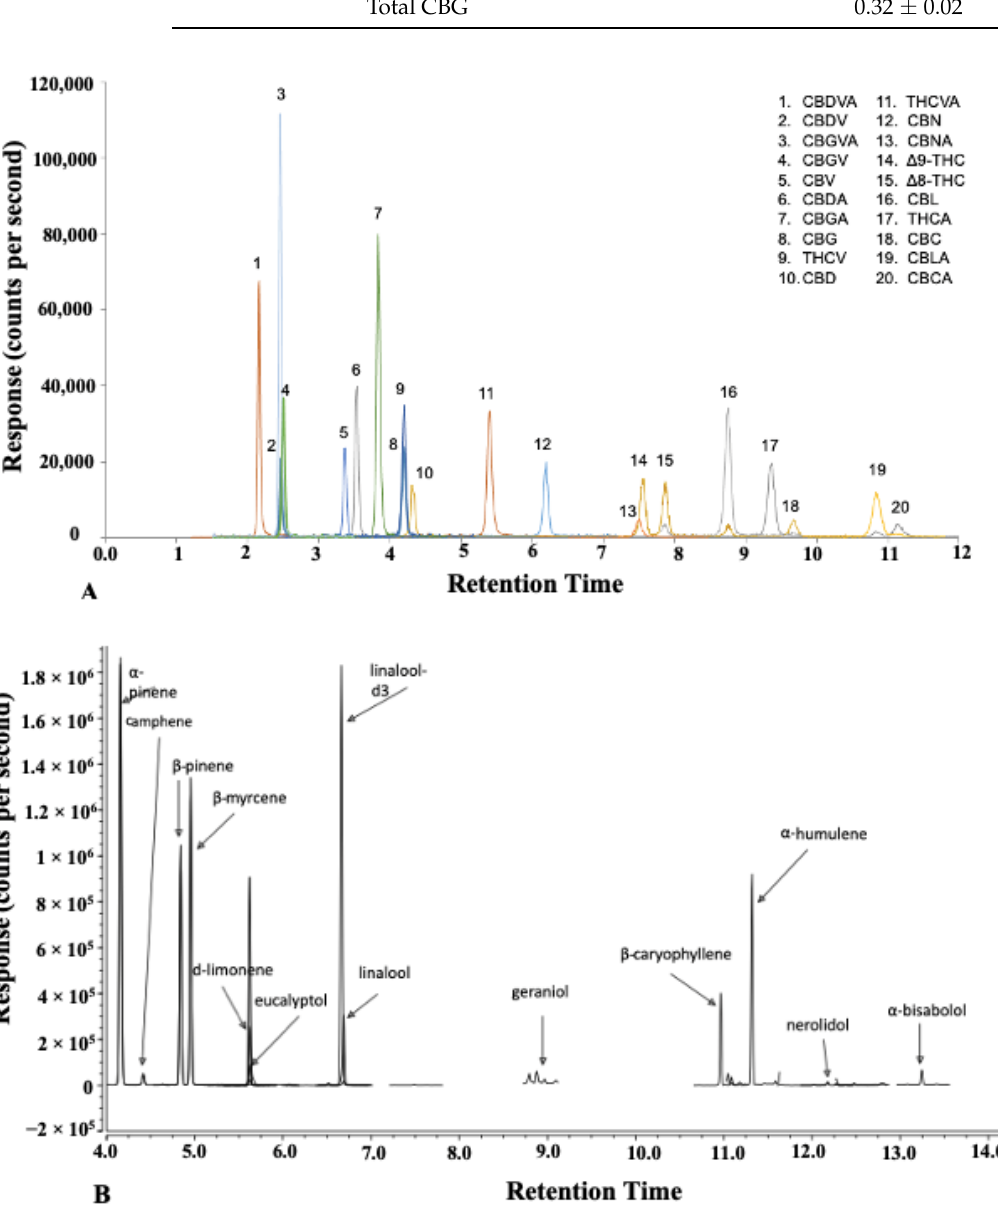
Figure 1. ( A ) LC-MS/MS chromatogram of cannabinoids and ( B ) GC-MS/MS chromatogram of terpenes.